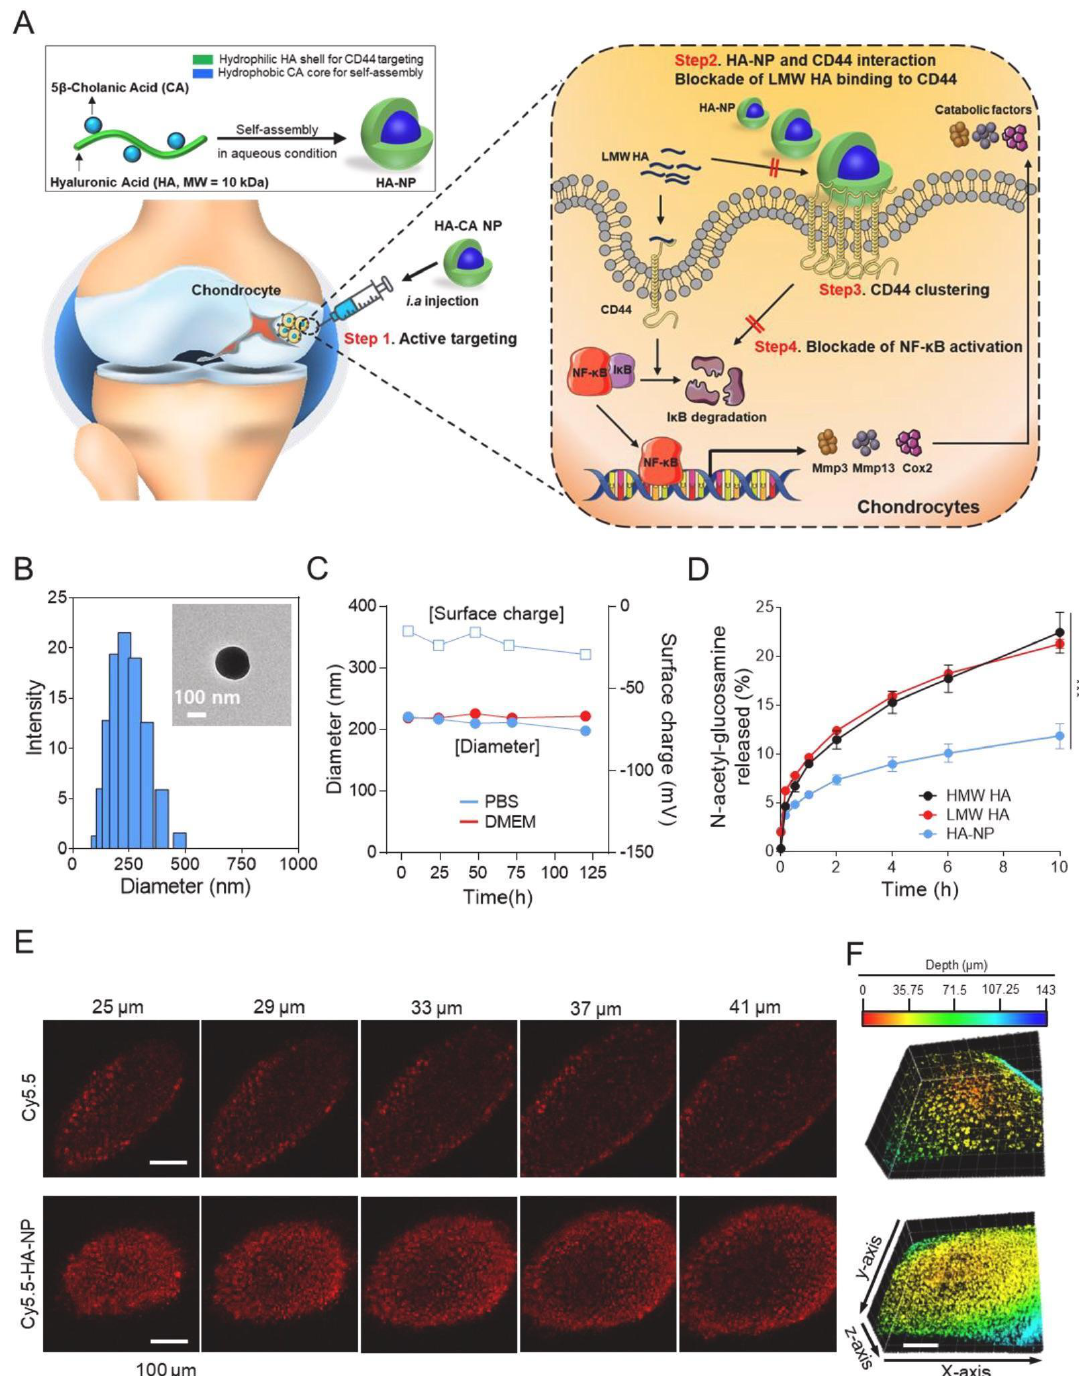
Figure 7. Characteristics of HA-NPs. ( A ) Schematic illustration of HA-NPs for treatment of OA. ( B ) TEM images and size distribution of HA-NP. Scale bar, 100 nm. ( C ) Time-dependent changes in particle size and surface charge of HA-NP in PBS and DMEM. Data are presented as mean ± SEM (n = 5). ( D ) Generation of N-acetyl-glucosamine after treatment of 1 mg/mL free HAs (10 kDa LMW and 2000 kDa HMW) or HA-NP with 100 IU/ml HYAL-II. Data are presented as mean ± SEM (n = 4). *** p < 0.001. ( E ) Representative serial images (25 –41 μm depth at intervals of 4 μm ) from the femoral cartilages after i.a. injection of Cy5.5 and Cy5.5-labeled HA-NP into normal mice. Scale bars, 100 μm. ( F ) Three-dimensional lateral view of the femoral cartilages after i.a. injection of Cy5.5 and Cy5.5-labeled HA-NP into normal mice. S cale bars, 100 μm. Reprinted with permission from [111].